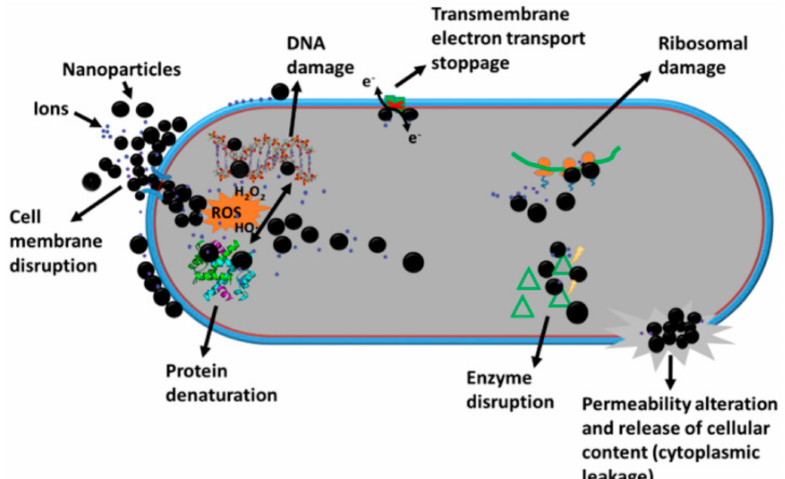
Figure 1. Possible mechanisms of action of nanoparticles in the